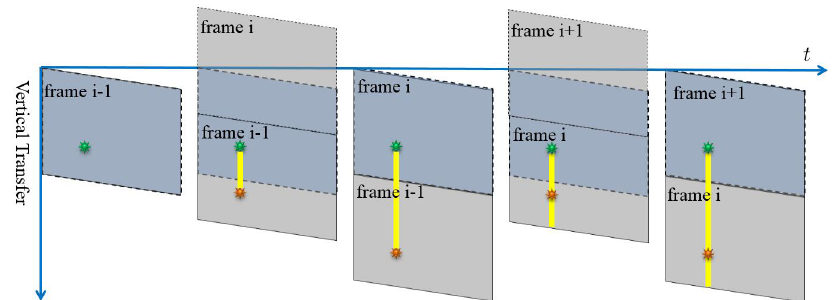
Figure 4. The process of the smear generation of a light source with constant lighting for frame i. The dark blue area indicates that the image sensor area and the gray area indicates the generated image. The orange sun symbol stands for the light source position in the final image and the green sun symbol stands for the light source position of the image sensor. The yellow line denotes the